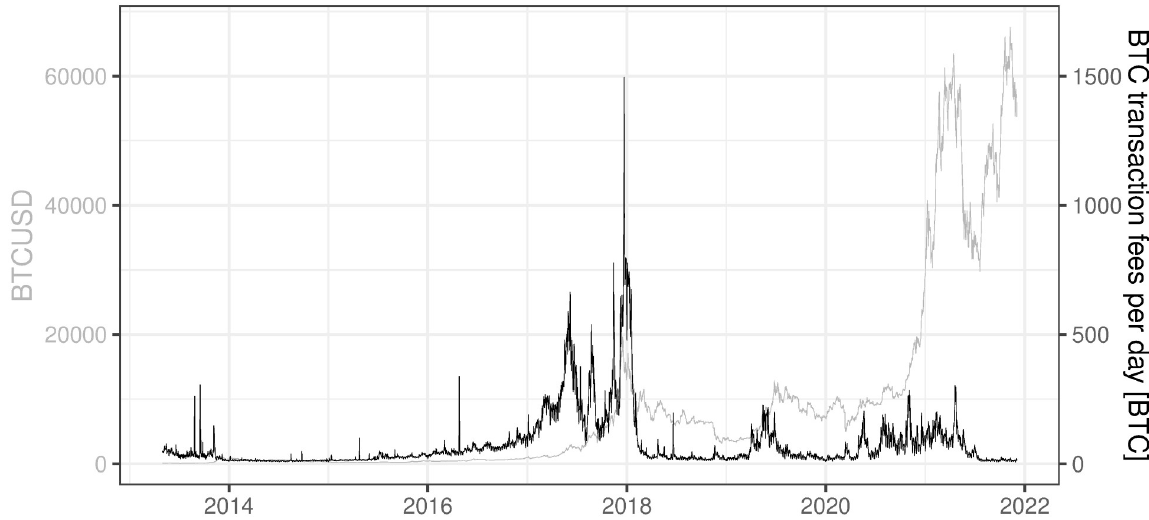
Fig 15. BTC transaction fees per day. Note: Data covers the period between 2013/05/01 to 2021/12/03. Source: https://charts.coinmetrics.io/ network-data/.